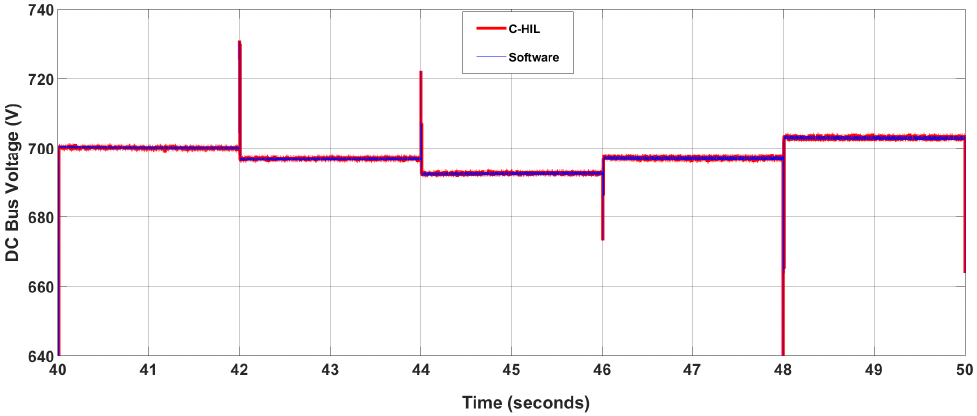
Figure 20. HIL DC bus voltage regulation under dynamical